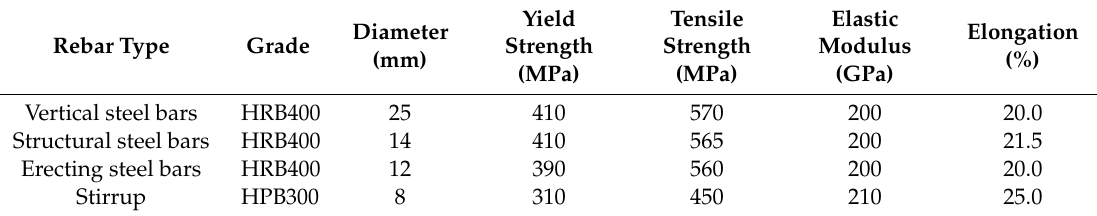
Table 1. Mechanical properties of the steel bars in the RC